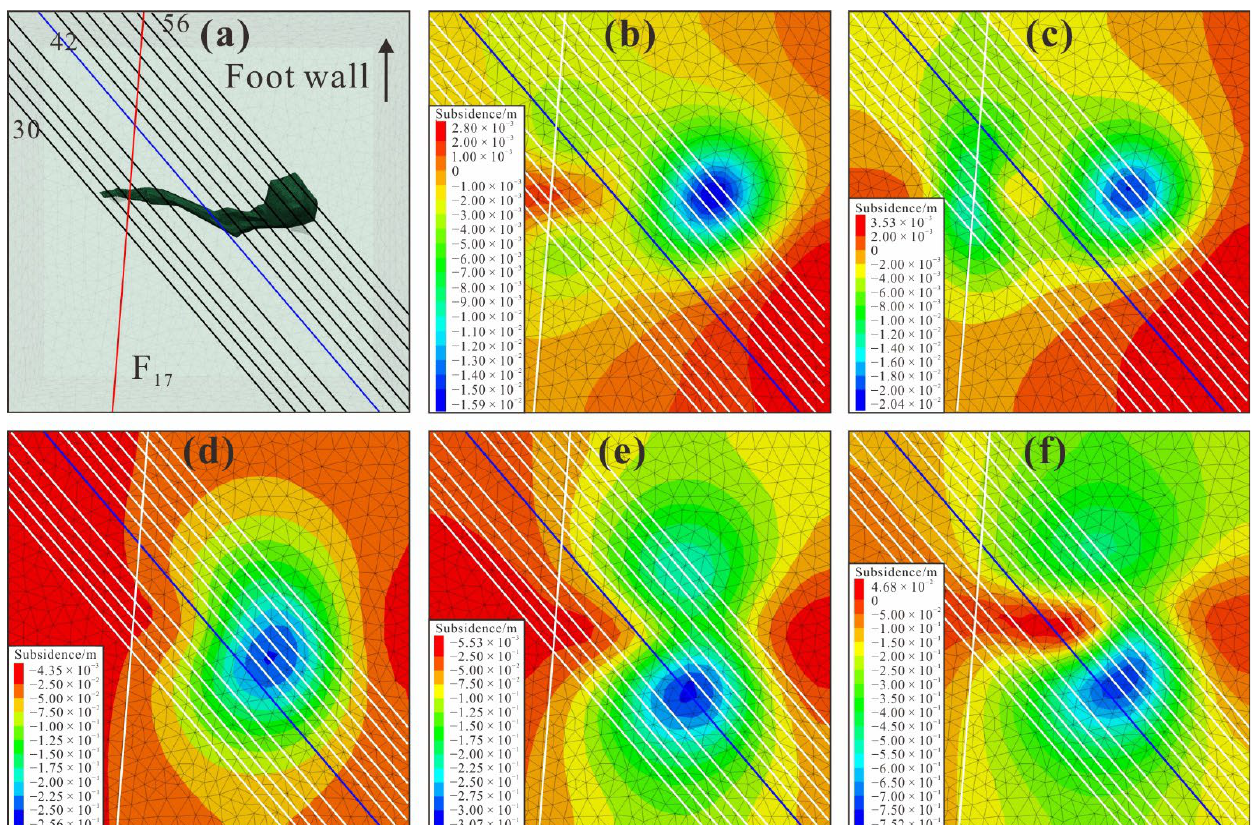
Figure 6. Numerical simulation results of surface subsidence. ( a ) Landmark location description; ( b ) surface deformation after the first mining step; ( c ) surface deformation after the second mining step; ( d ) surface deformation after the third mining step; ( e ) surface deformation after the fourth mining step; ( f ) surface deformation after the fifth mining step.